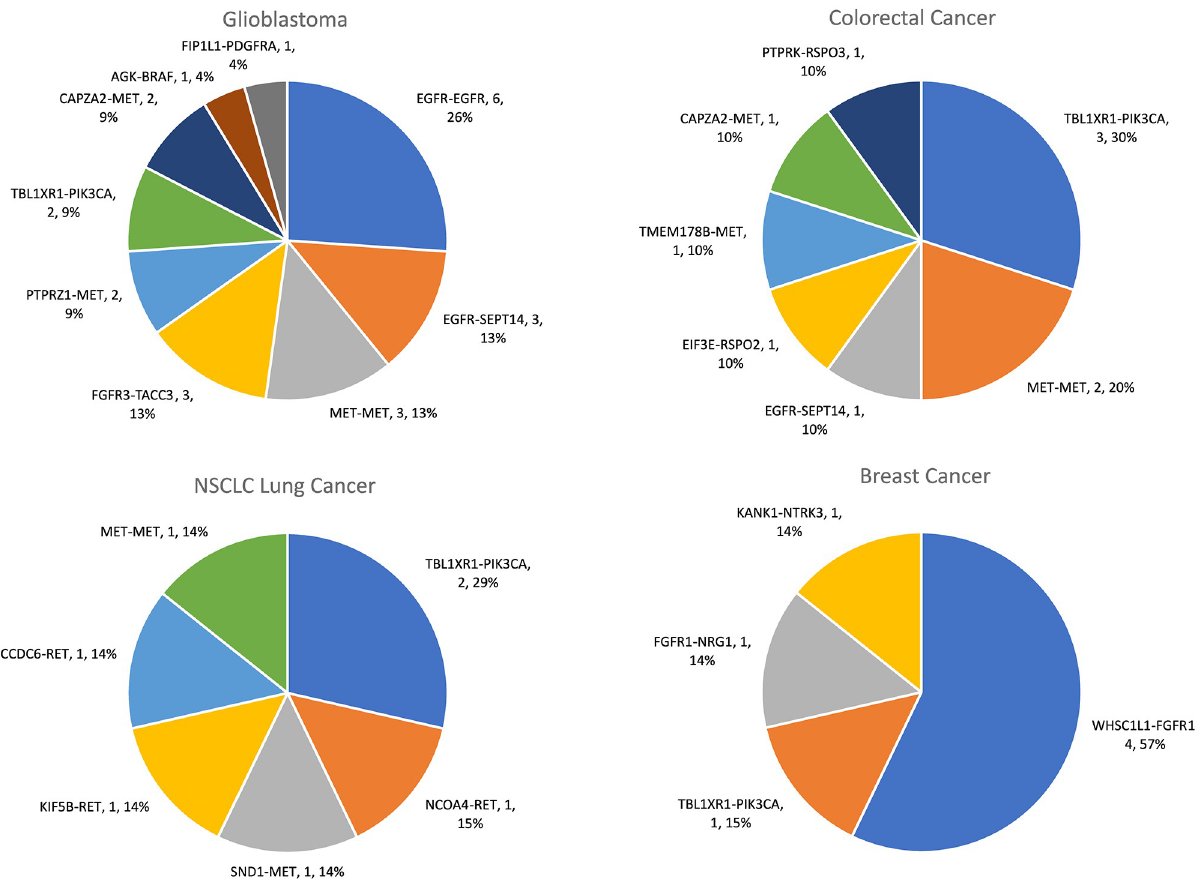
Fig 3. Frequency of actionable gene fusions in glioblastoma, colorectal, NSCLC and breast cancers.